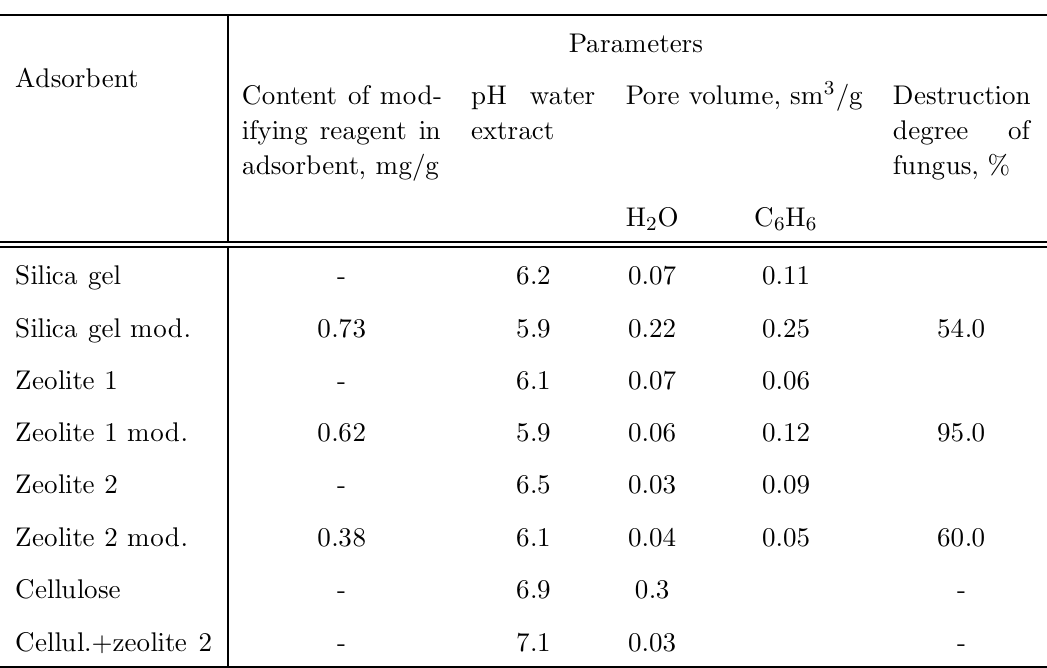
Table 9 The in®uence of modi› cation of synthetic and natural adsorbents on structure and sorption